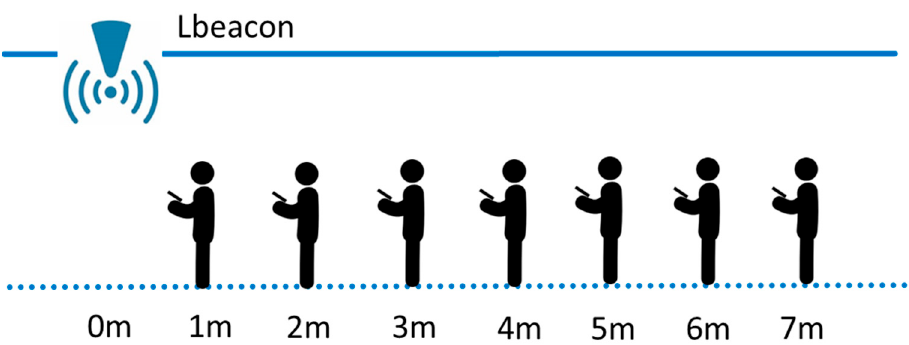
Figure 4. Collecting received signal strength indicator (RSSI) samples at different distances.